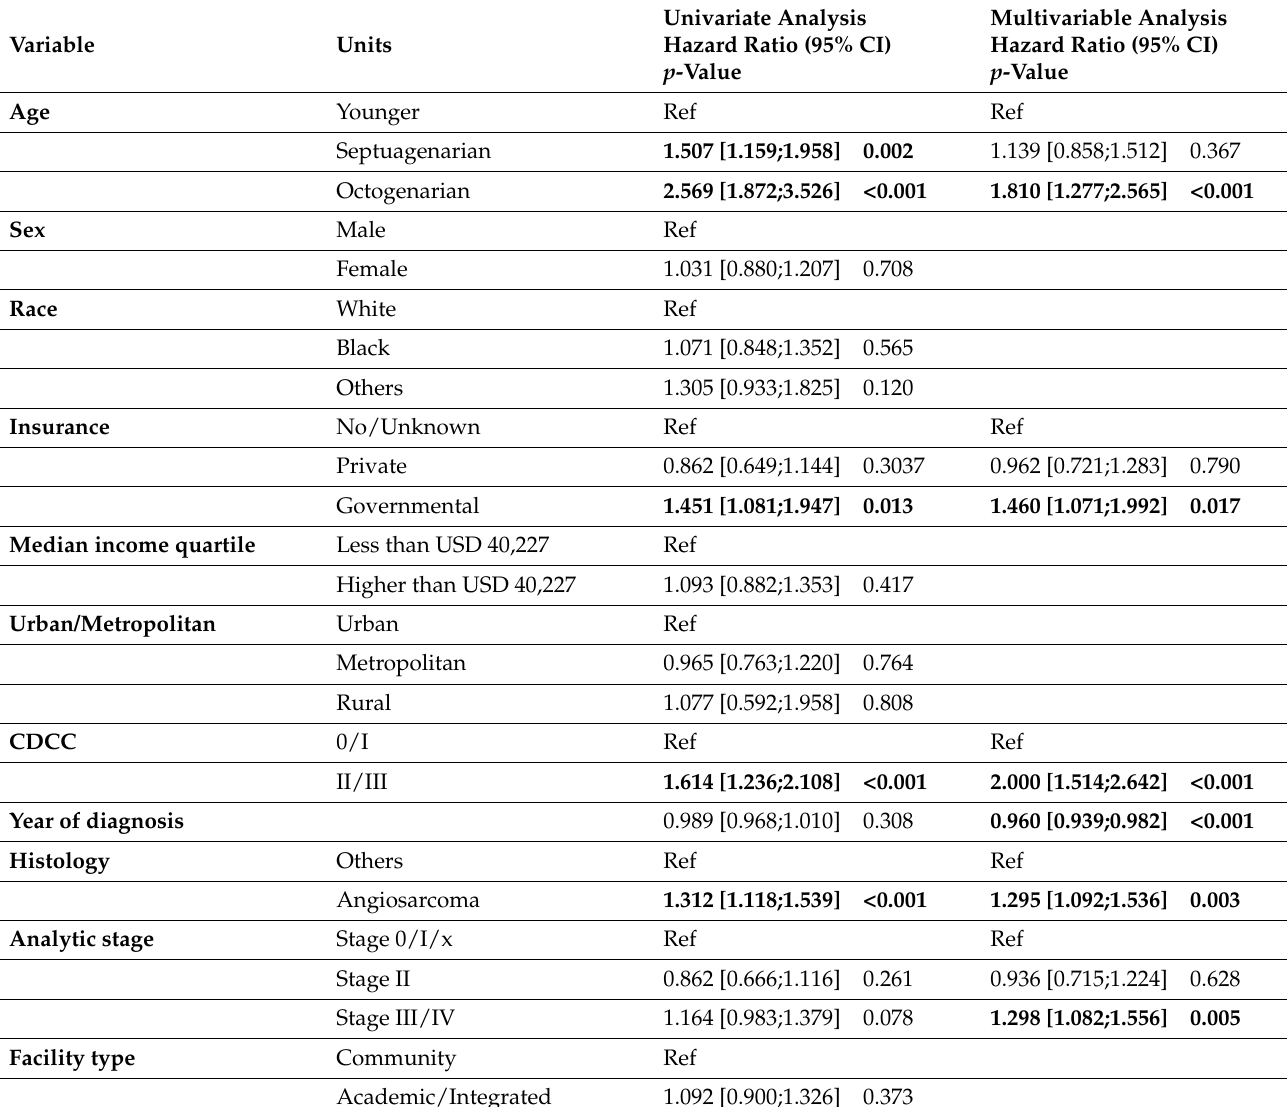
Table 2. Independent predictors of late mortality among the entire